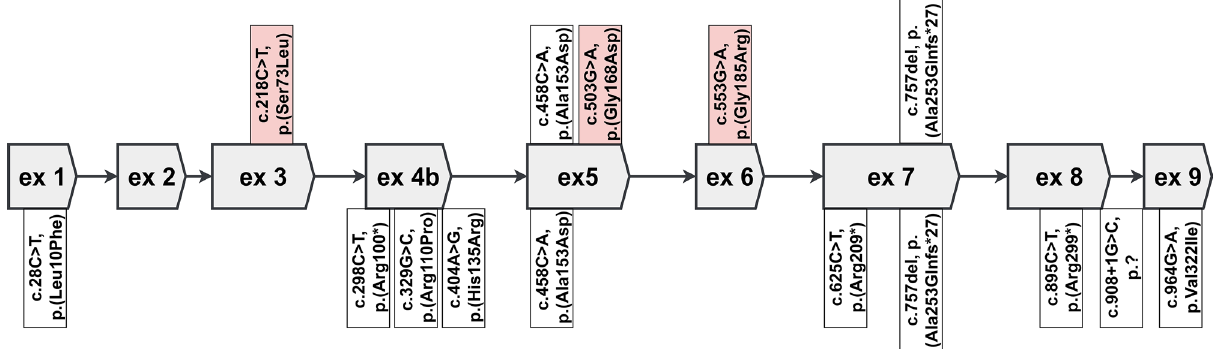
Figure 5. The SORD gene structure and published variants. Above the gene: variants found in this study. Below the gene are previously published variants. Red flags describe novel variants found in this